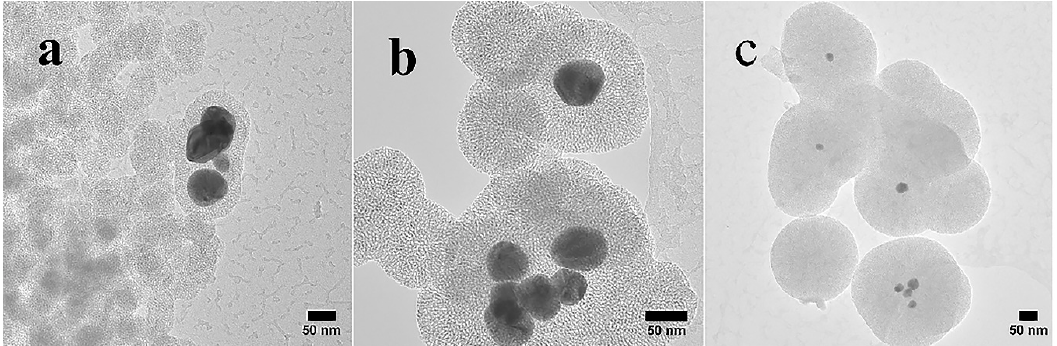
Figure 5. TEM images showing the surface morphology of both core-shell Ag@SiO 2 and core-free silica particles: ( a ) S1 with 50 mL ethanol, ( b ) S2 with 100 mL ethanol and ( c ) S3 with 150 mL ethanol.